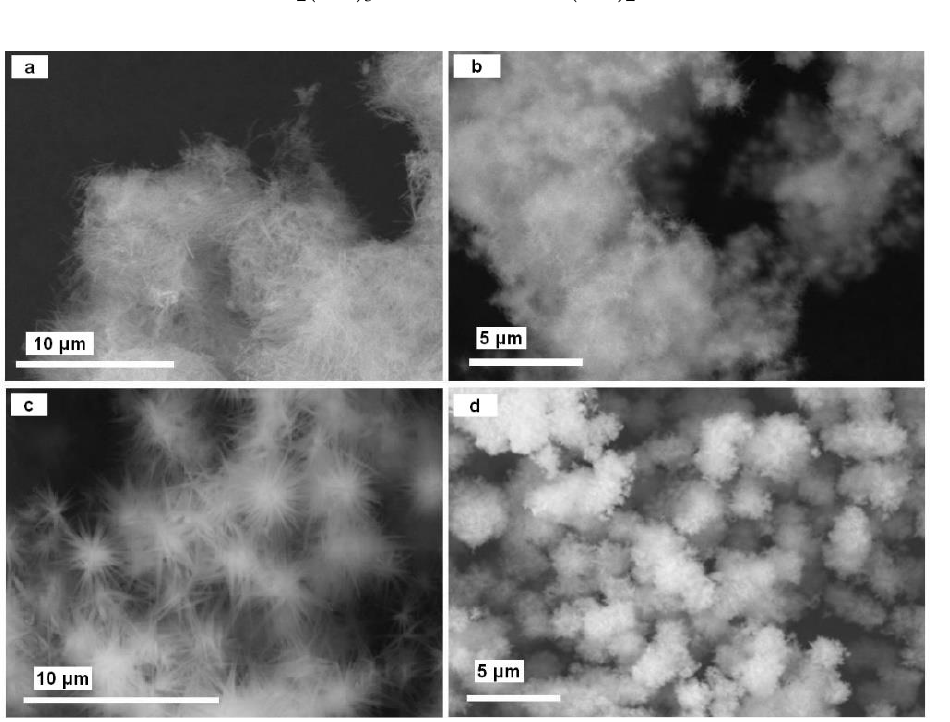
Figure 4. SEM images of powders: obtained by NaOH/NH 3 (aq) treatment of the Cu 2 (OH) 3 Cl (sample A ) ( a , b ) and Cu 2 (OH) 3 Cl (sample B ) ( c ) powders; obtained by NaOH treatment of the Cu 2 (OH) 3 Cl (sample B ) powder ( d ).